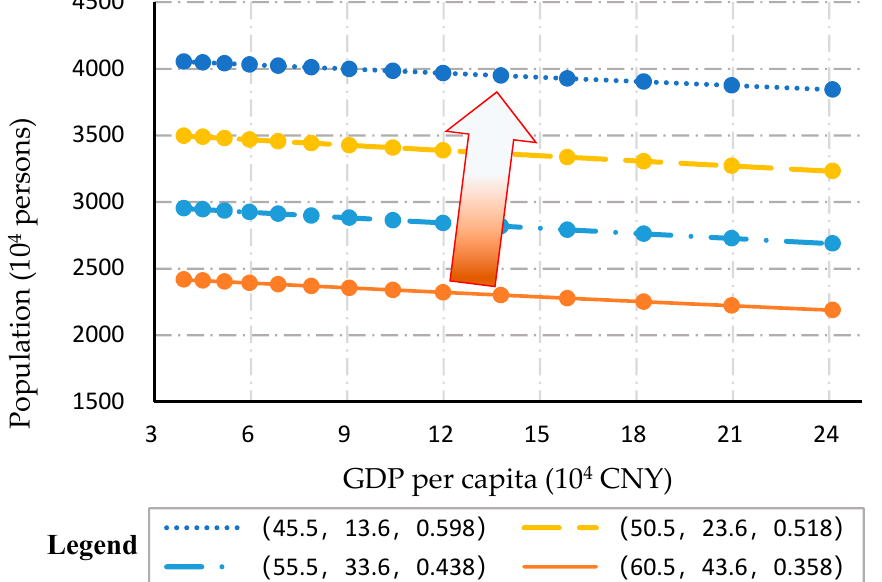
Figure 1. The pedigree chart of the water resources carrying capacity of Xinjiang.